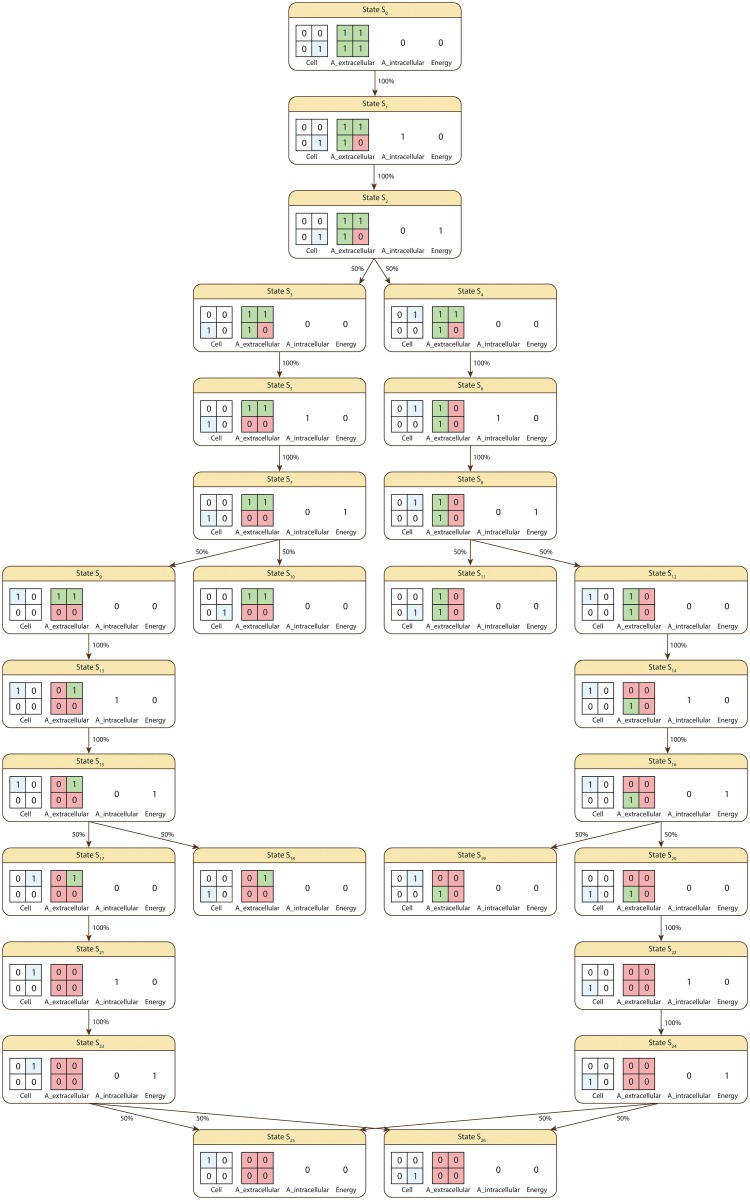
The state space of the system i.e. all possible states which can be reached from the initial state S0.Cell and A_extracellular are the spatial state variables representing the position of the cell, respectively distribution of nutrient A in the environment. A_intracellular and Energy represent the intracellular availability of nutrient A, respectively energy. The percentage associated with the arrows connecting each pair of states represents the probability of transitioning from one state to the other.